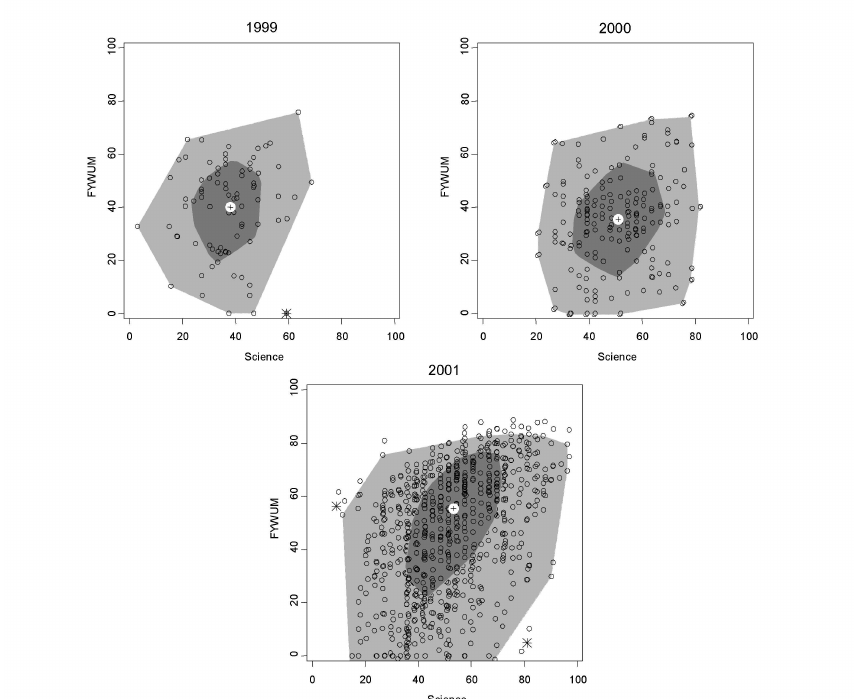
Figure 10: Bagplots of FYWUM and Science for 1999, 2000 and 2001.